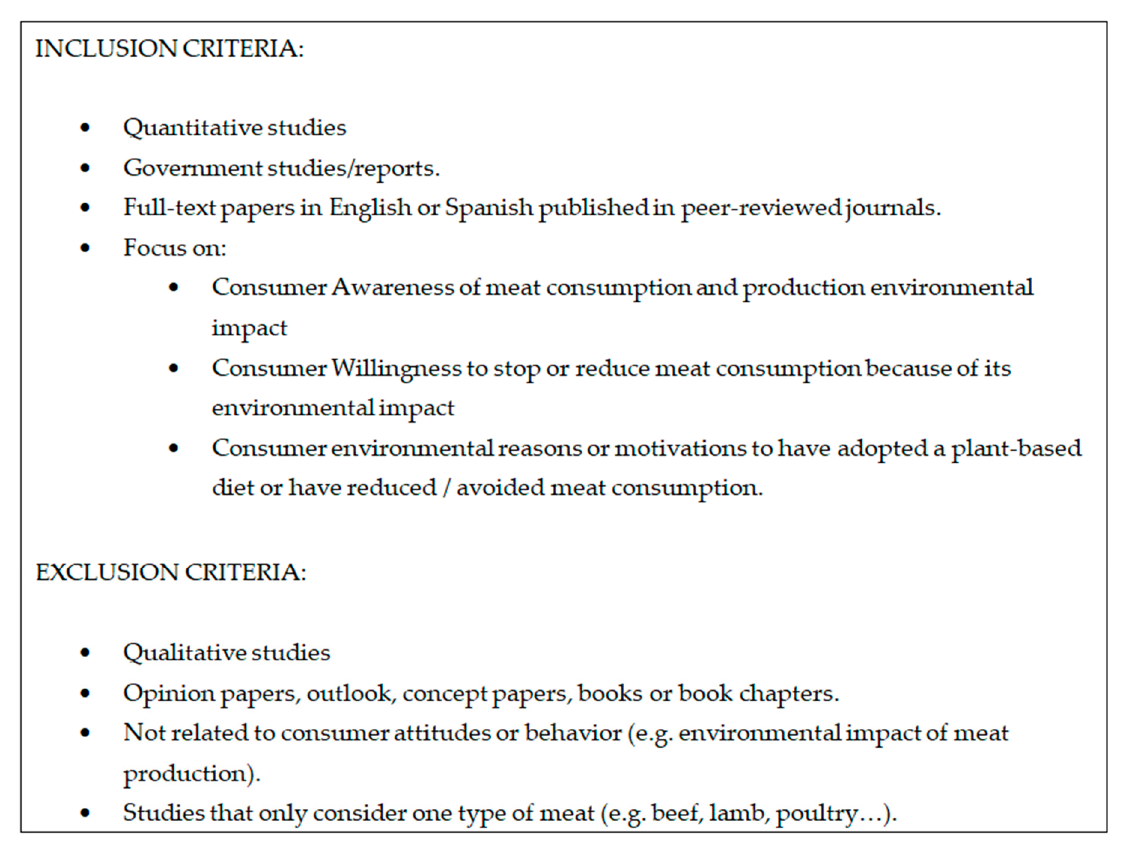
Figure 1. Eligibility criteria.